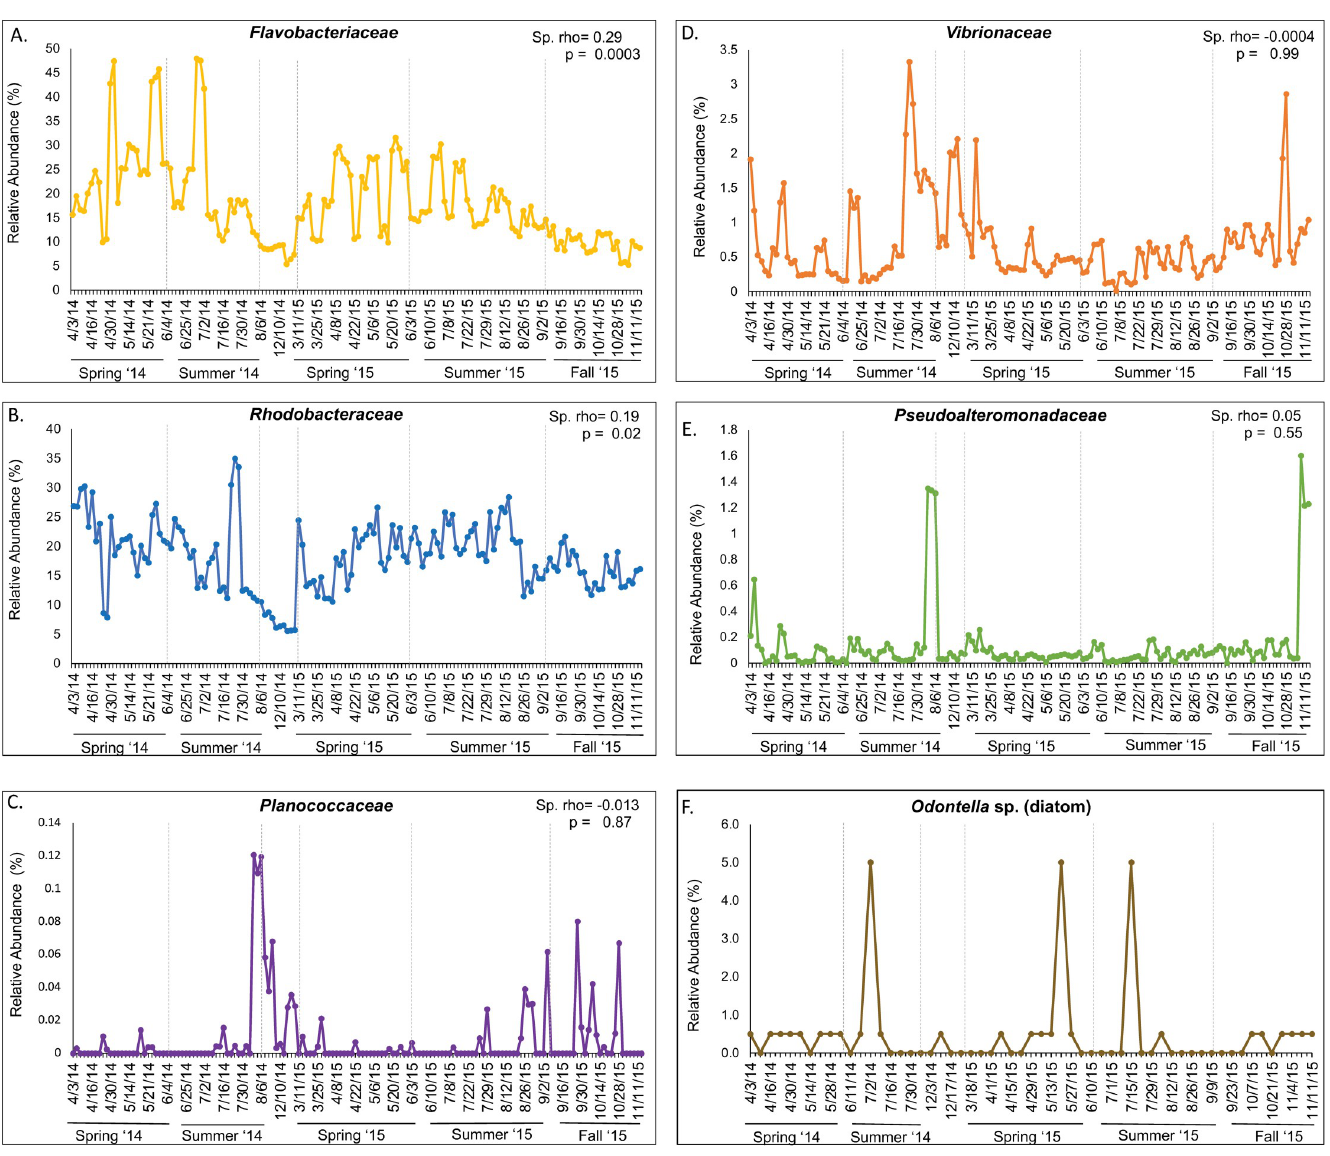
Fig 9. Relative abundance of the bacterial families and Odontella diatom at Santa Cruz Wharf, Monterey Bay, CA, surveyed between 2014–2015. (A) Flavobacteriaceae (B) Rhodobacteraceae (C) Planococcaceae (D) Vibrionaceae (E) Pseudoalteromonadaceae (F) Odontella sp. Bacterial abundances were determined via 16S rRNA amplicon sequencing, while Odontella diatom abundance was qualitatively surveyed using microscope counts. The strength of the association between the bacterial groups and the Odontella population was measured using Spearman rho correlation coefficient (Sp. rho) at p = 0.05.